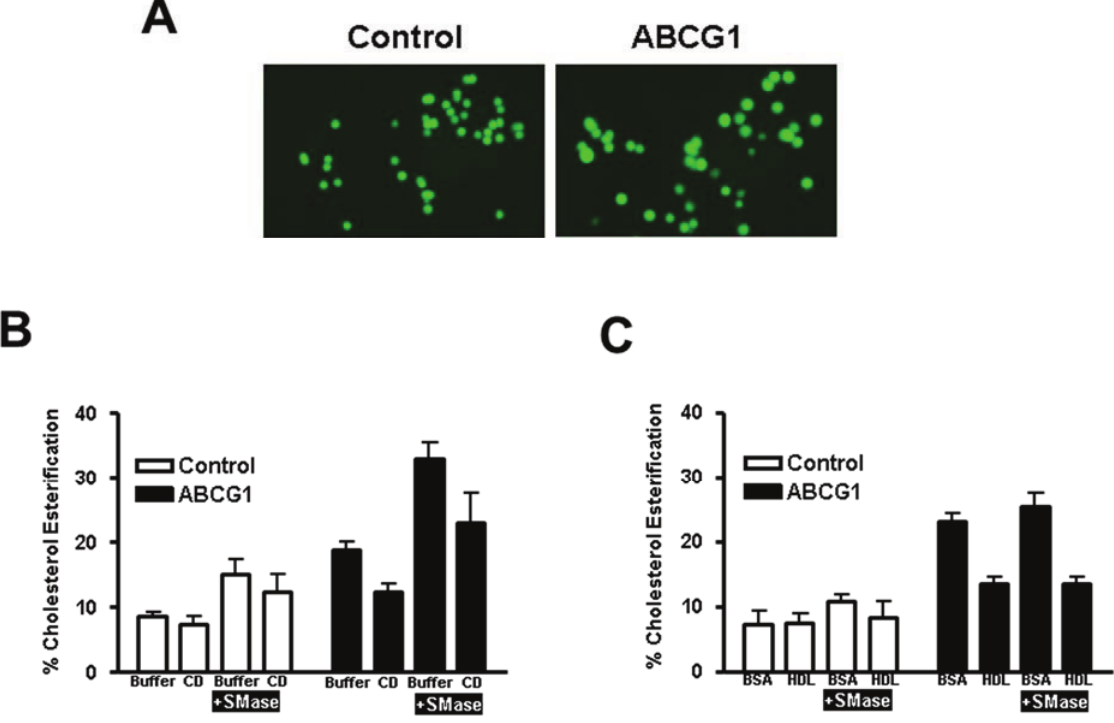
Figure 4. ABCG1 enhances cholesterol esterification. ( A ) Confocal microscopic 3D reconstruction of Nile Red-stained cytoplasmic lipid droplets (maximum projection